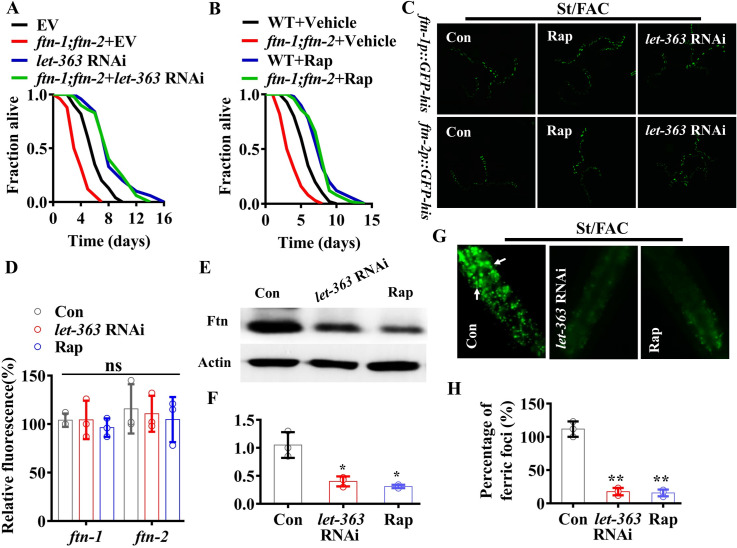
TOR regulates ferritin protein levels during S. Typhimurium infection.(A and B)
ftn-1(ok3625);ftn-2(ok404) double mutations did not influence the survival rate of the worms subjected to let-363 RNAi (A) or rapamycin (Rap) treatment (B) after S. Typhimurium infection in the presence of ferric ammonium citrate (FAC, 100 μM) (Log-rank test). Underlying data are available in S1 Table. (C)
let-363 RNAi or rapamycin treatment did not alter the expression of ftn-1p::gfp-his and ftn-2p::gfp-his in worms infected with S. Typhimurium. (D) Fluorescence intensity of ftn-1p::gfp-his and ftn-2p::gfp-his. These results are mean ± SD of three independent experiments performed in triplicate. (n = 30 worms per experiment). ns, not significant (one-way ANOVA followed by a Student-Newman-Keuls test). Underlying data are available in S2 Table. (E)
let-363 RNAi or rapamycin treatment suppressed the levels of ferritin protein in worms infected with S. Typhimurium in the presence of FAC. The blots are typical of three independent experiments. Con, control. (F) Quantification of ferritin protein levels from Western blot (E). These results are mean ± SD of three experiments. *P < 0.05 (one-way ANOVA followed by a Student-Newman-Keuls test). Underlying data are available in S2 Table. (G) Representative images of ferric foci in worms subjected to let-363 RNAi infected with S. Typhimurium in the presence of FAC. The arrows denote representative ferric foci. (H) Percentage of ferric foci. These results are mean ± SD of three independent experiments. (n = 20 worms per experiment). **P < 0.01 (one-way ANOVA followed by a Student-Newman-Keuls test). Underlying data are available in S2 Table.